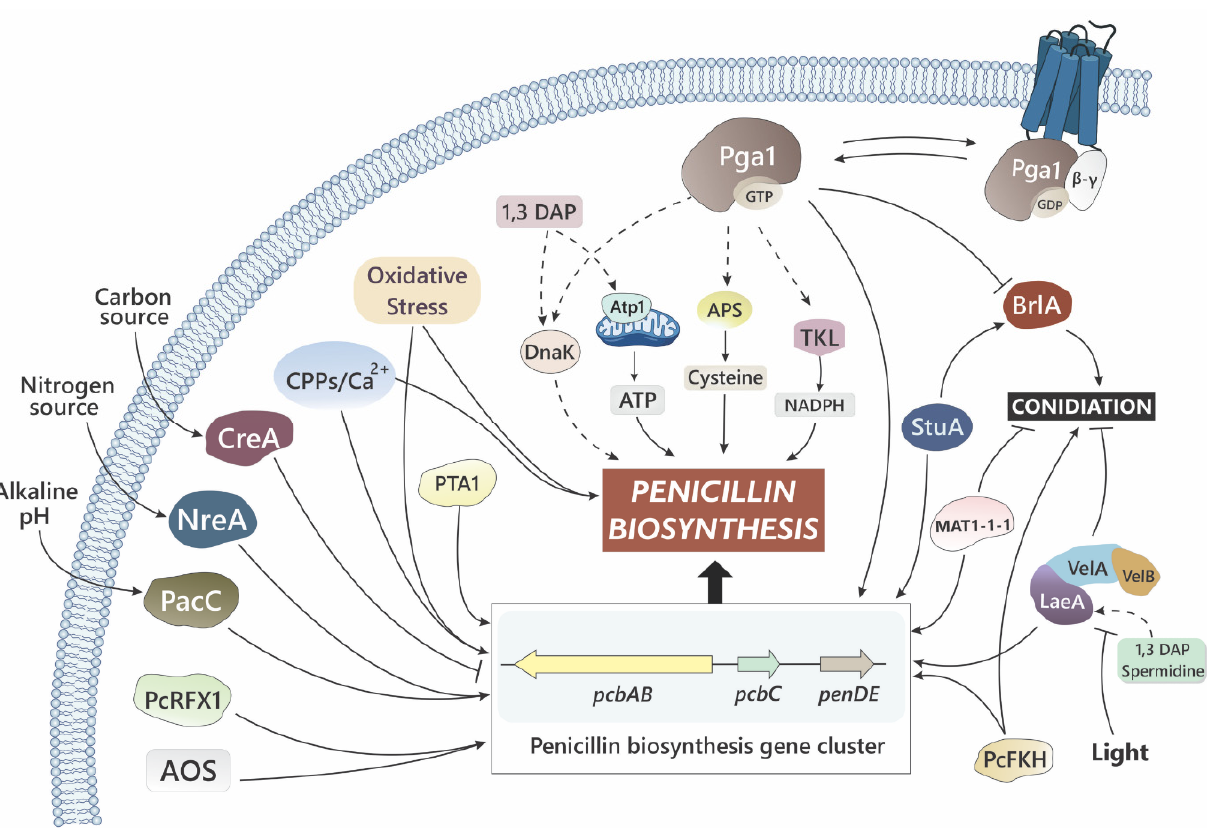
Figure 3. Outline of regulatory signals, transduction pathways, and proteins controlling expression of penicillin genes and penicillin production in P. chrysogenum .